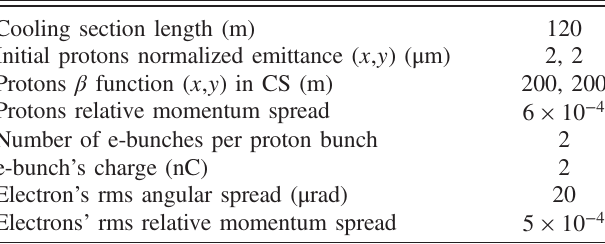
TABLE II. Parameters of the EIC cooler operating at γ ¼ 25 . 4